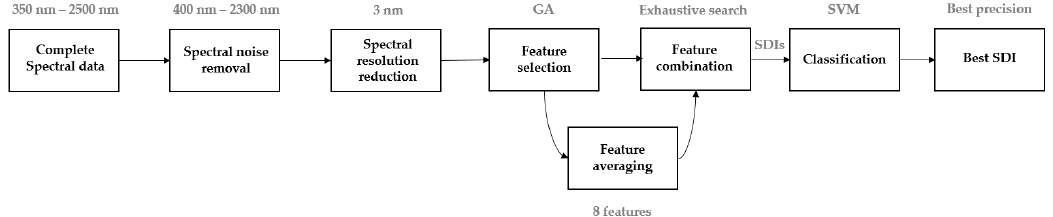
Figure 4. Systematical approach and development of SDIs from hyperspectral reflectance data.